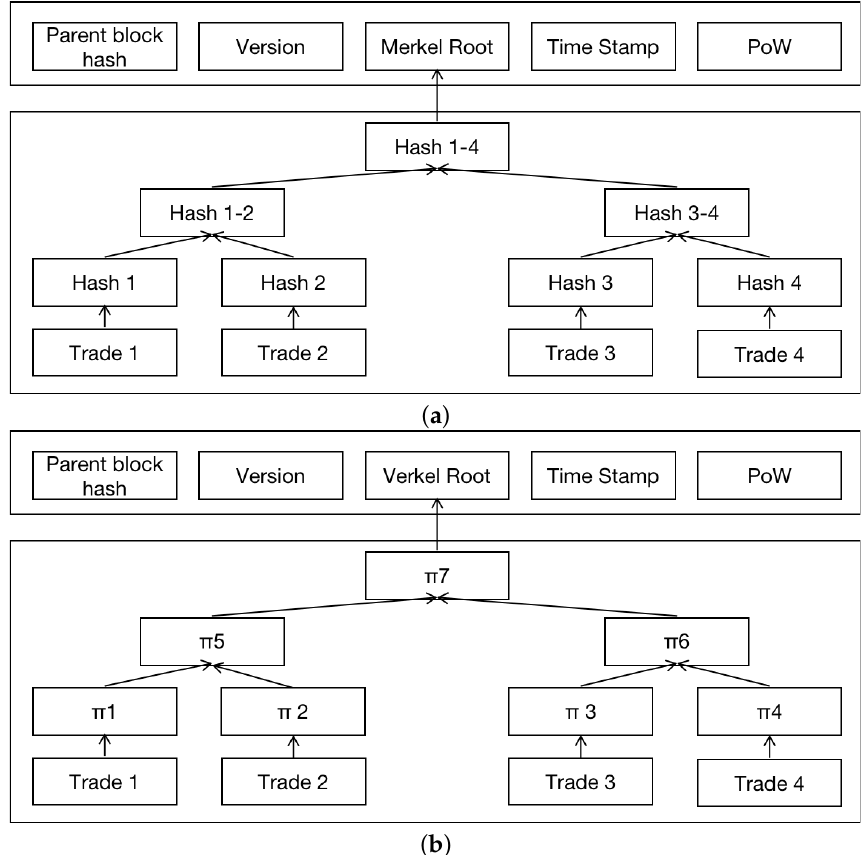
Figure 2. Merkle tree and Verkle tree. ( a ) Merkle tree. ( b ) Verkle